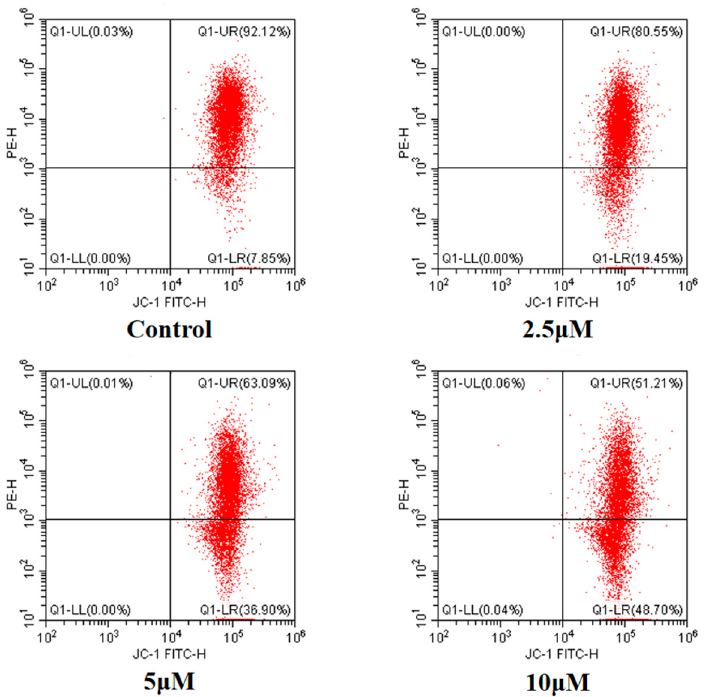
Figure 4. Effects of hybrid A8 on MCF-7 cells MMP, MCF-7 cell were treated with compound A8 at 0, 2.5, 5 and 10 µ M for 48 h and stained with TMRE before flow cytometry analysis. Data were expressed as mean ± SD (n = 3). p < 0.05 versus the controls (0 μ M).